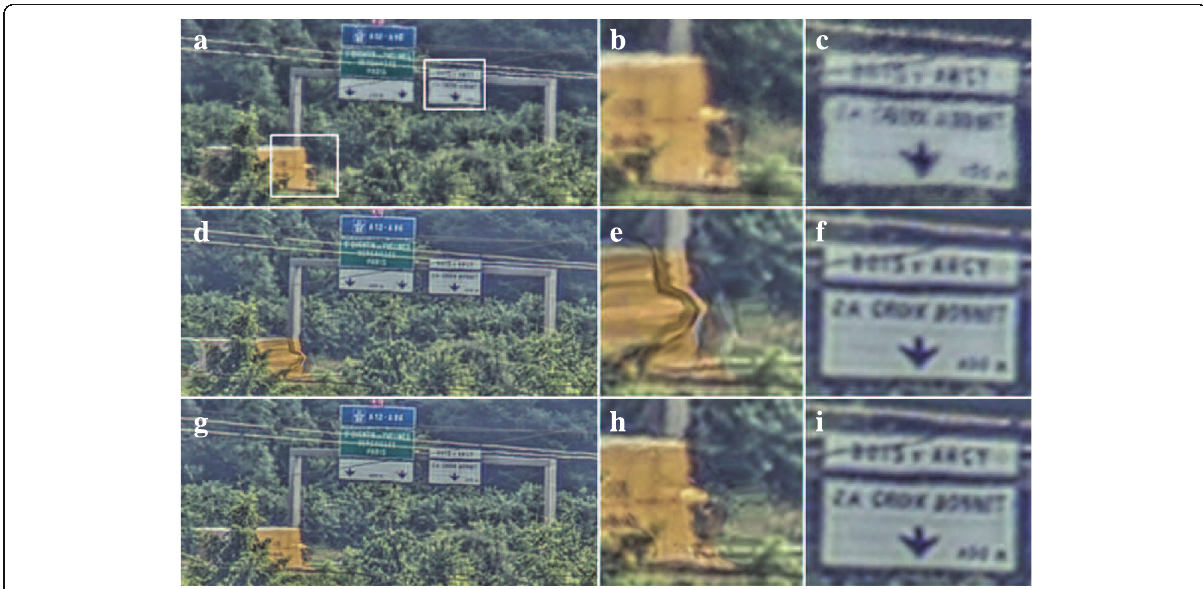
Fig. 8 Turbulence mitigation on a highway scene. The top row shows a still from the raw video ( a ) and two cut-outs ( b - c ). The middle row shows ( d - f ) the processing results for dynamic turbulence mitigation with TV-L1 optical flow without occlusion compensation. The bottom row ( g - i ) shows the result when the occlusion compensation is applied. The height of the truck is about 100 pixels